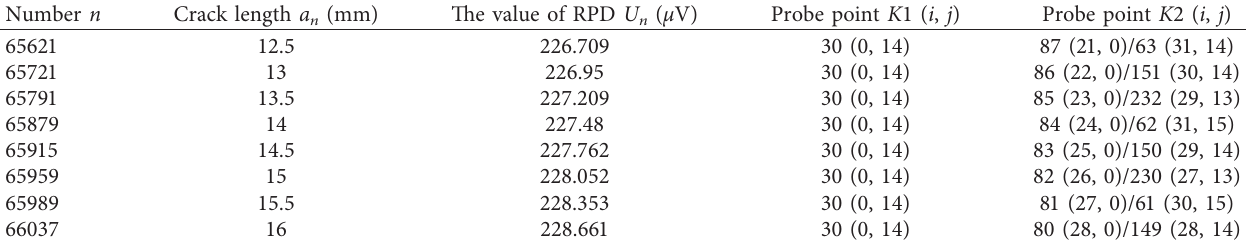
Figure 11: The optimization of measurability with GA. (a) The distribution of the RPD before GA optimization. (b) The distribution of the RPD after GA optimization. Table 3: The value of the RPD after optimization of measurability.